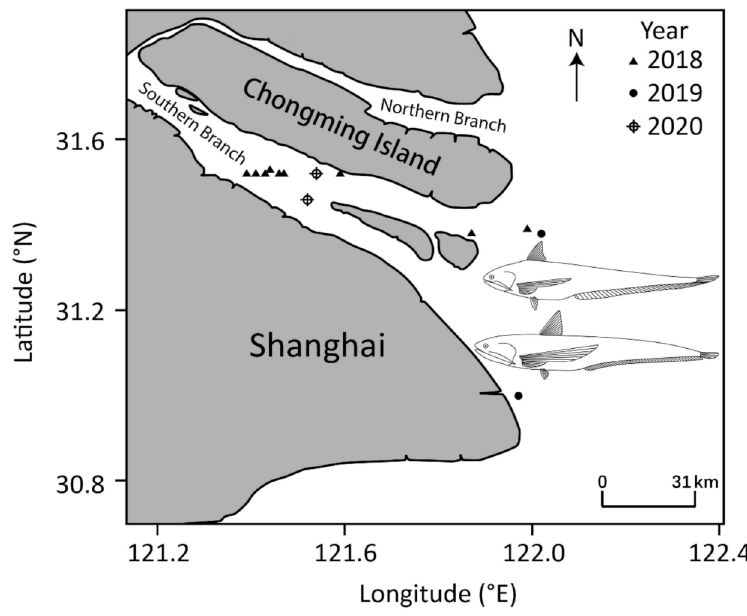
Figure 1. Survey sites for C. mystus (2018–2020) and C. nasus (2019–2020) in the Yangtze River Estuary, China.